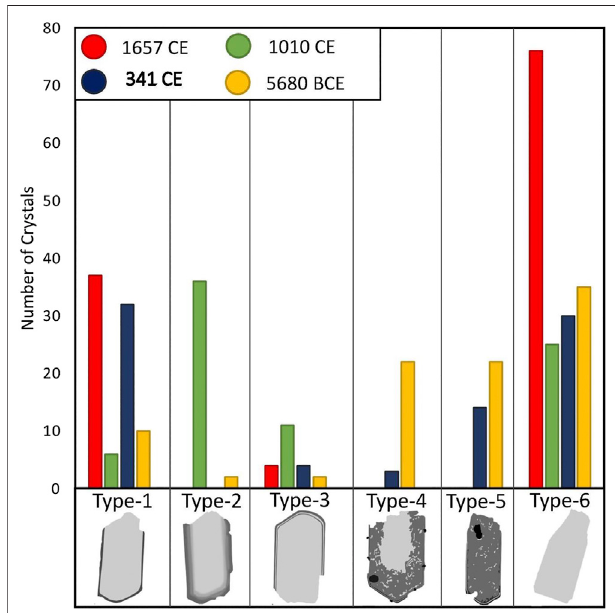
FIGURE 8 | Histogram showing the number of each crystal type per eruption. Each eruption is made up of a different proportion of each crystal type, with not all crystal types present in the different eruptions. The 1657 Cal. CE eruption is composed of entirely simple crystals showing no resorption, with unzoned crystals making up the largest crystal population. The 1010 Cal. CE eruption is also entirely composed of simple crystals and is predominantly composed of crystals with diffuse zoning. This crystal type is the most abundant in the 1010 Cal. CE eruption, with only one or two crystals observed in other eruptions. The ∼ 341 Cal. CE eruption is also mostly composed of simple crystals with small populations of fully resorbed and partially resorbed crystals. The 5680 Cal. BCE eruption has the largest populationsofresorbedcrystalsandonly smallpopulationsofsimplecrystals. This highlights that the complex, resorbed crystals are only found in the older